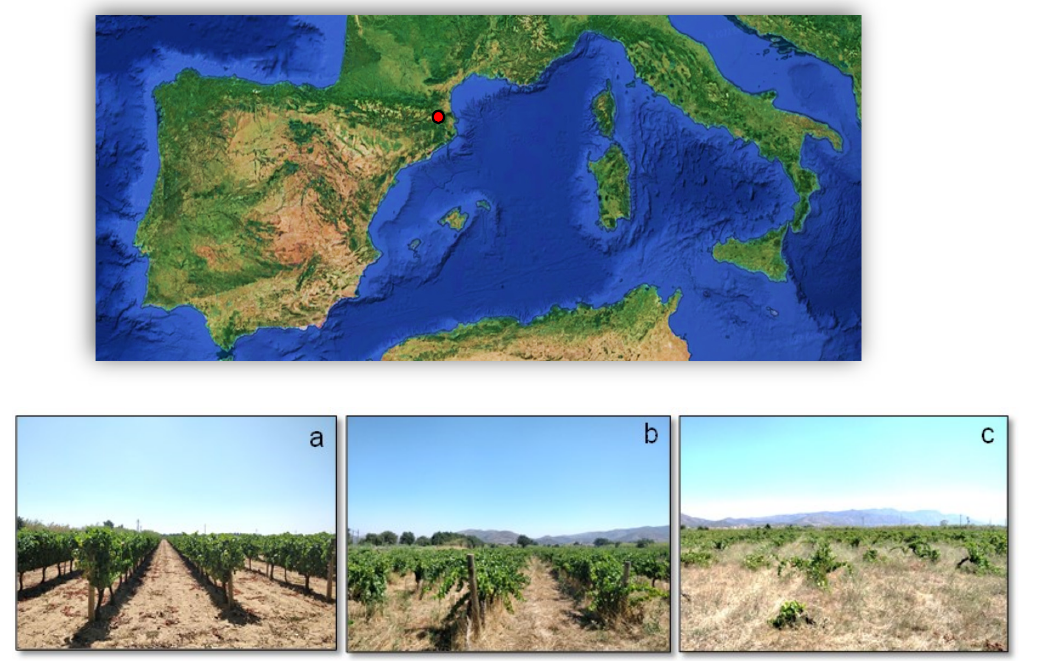
Figure 1. Geographical localization of the study area in the Girona province (Catalonia, Spain), and view of the three vineyards under ( a ) intensive management, ( b ) regenerative management, and ( c ) minimum impact management, respectively.